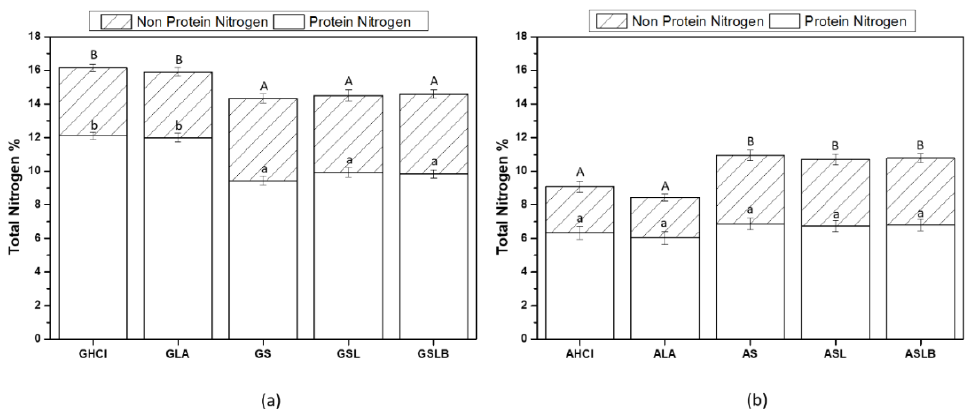
Figure 3. Total nitrogen (non-protein and protein nitrogen) content of ( a ) globulin fraction obtained by controls (GHCl, GLA) and fermentations (GS, GSL, GSLB), ( b ) albumin fraction obtained by controls (AHCl and ALA) and fermentations (AS, ASL, ASLB). Different capital letters represent significant differences in total nitrogen content, and small case letters represent significant differences in protein nitrogen among different samples (Tukey’s post hoc test).